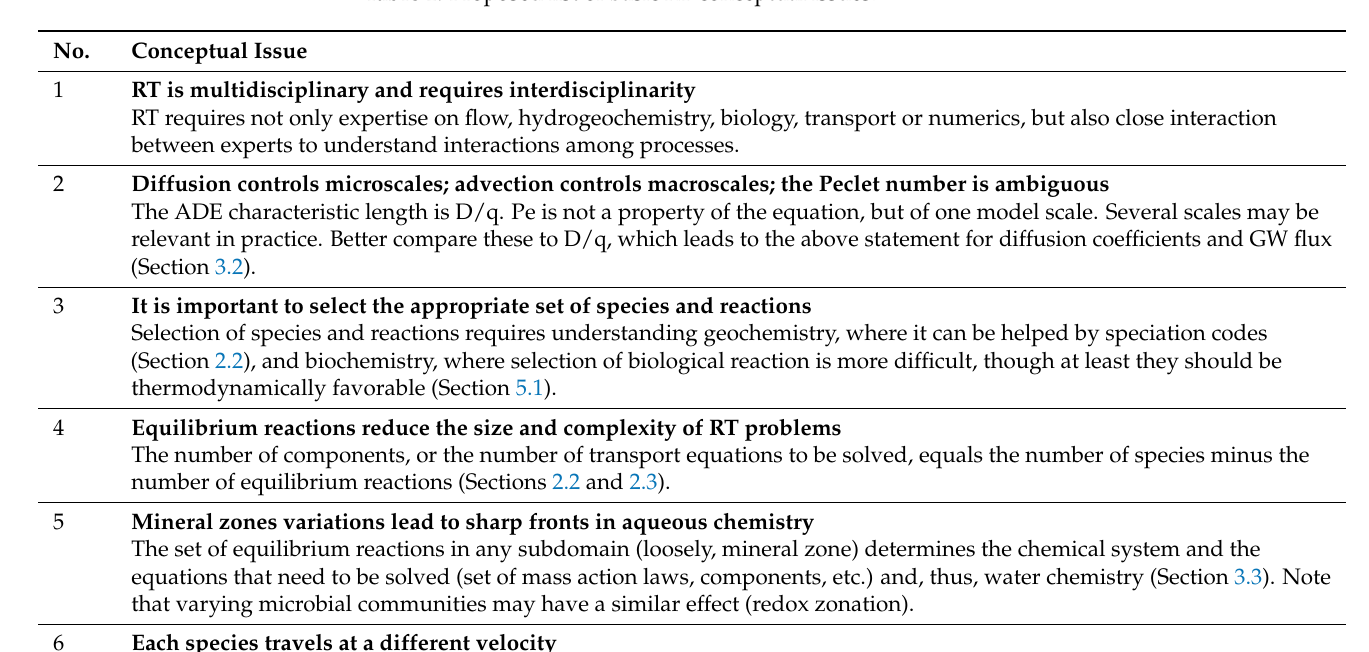
Table 1. Proposed list of basic RT conceptual